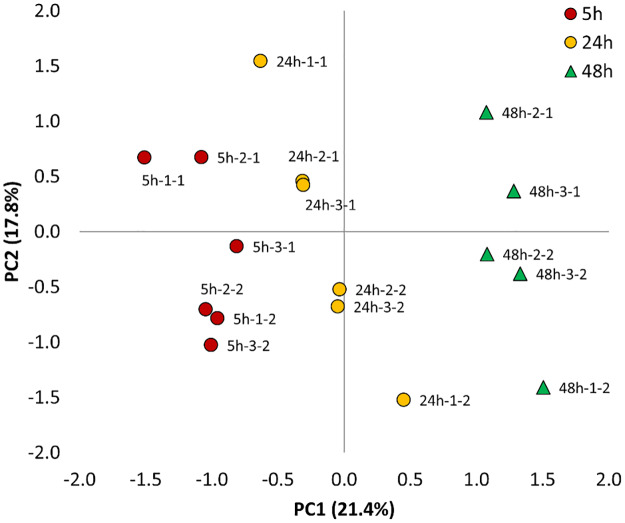
Principal component analysis of the 150 quantified proteins in all biological and technical replicates across the three time points (5, 24 and 48 h) in HK-2 cells treated with HG (25 mM glucose)-hypoxia (1% O2) in comparison to NG (5.5 mM glucose)-normoxia (21% O2).The first number after the different time points indicates the biological replicate, and the second number indicates the technical replicate.